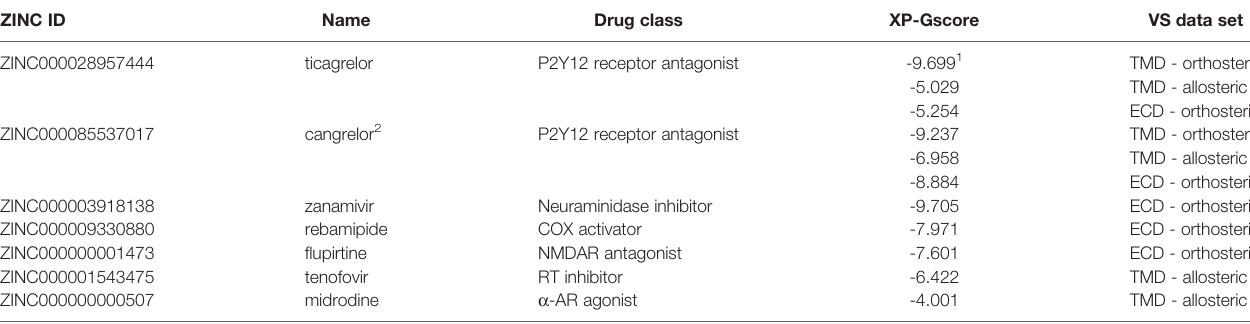
TABLE 1 | Compounds selected by virtual screening for testing in